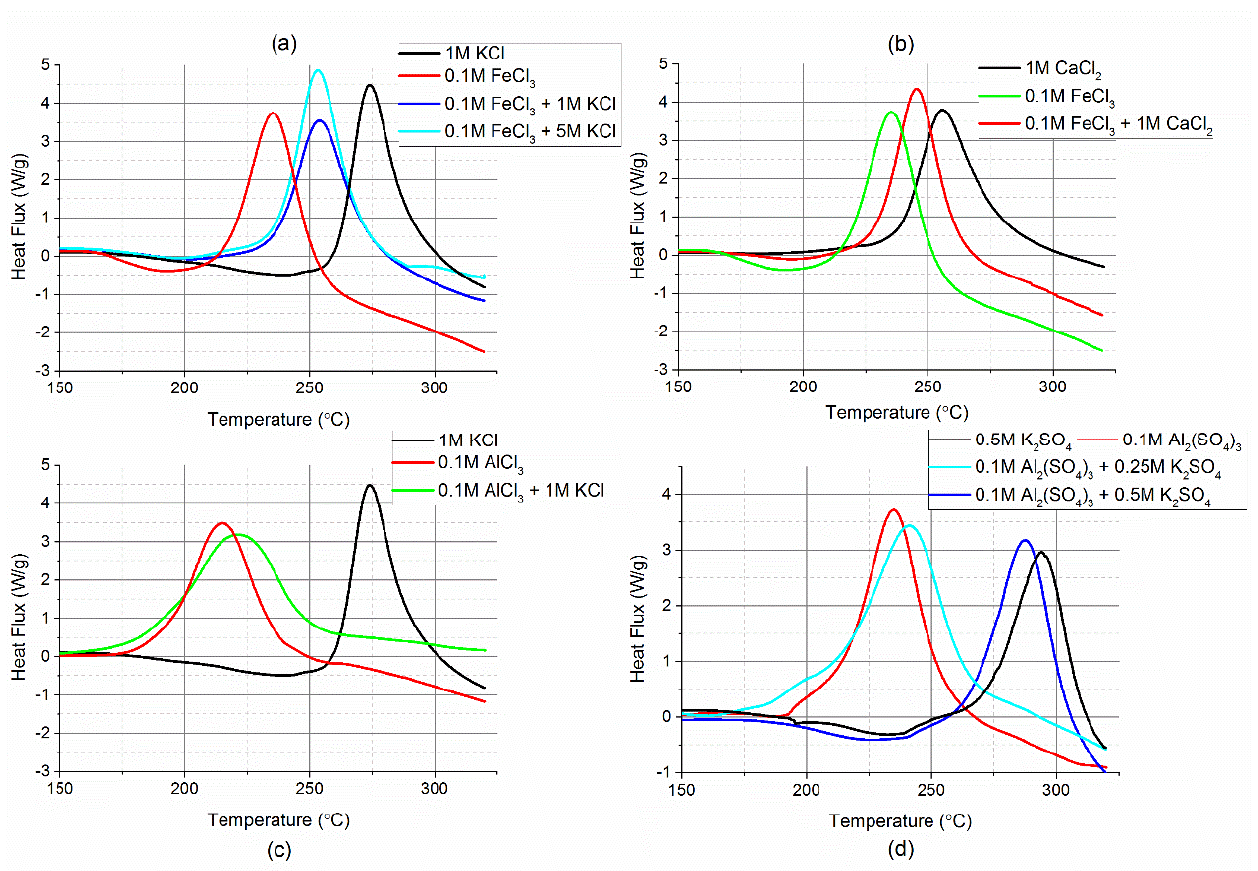
Figure 5. Effect of mixing two salts on the HTC of cellulose. ( a ) iron and potassium chloride, ( b ) iron and calcium chloride, ( c ) aluminium and potassium chloride, and ( d ) aluminium and potassium sulphate.